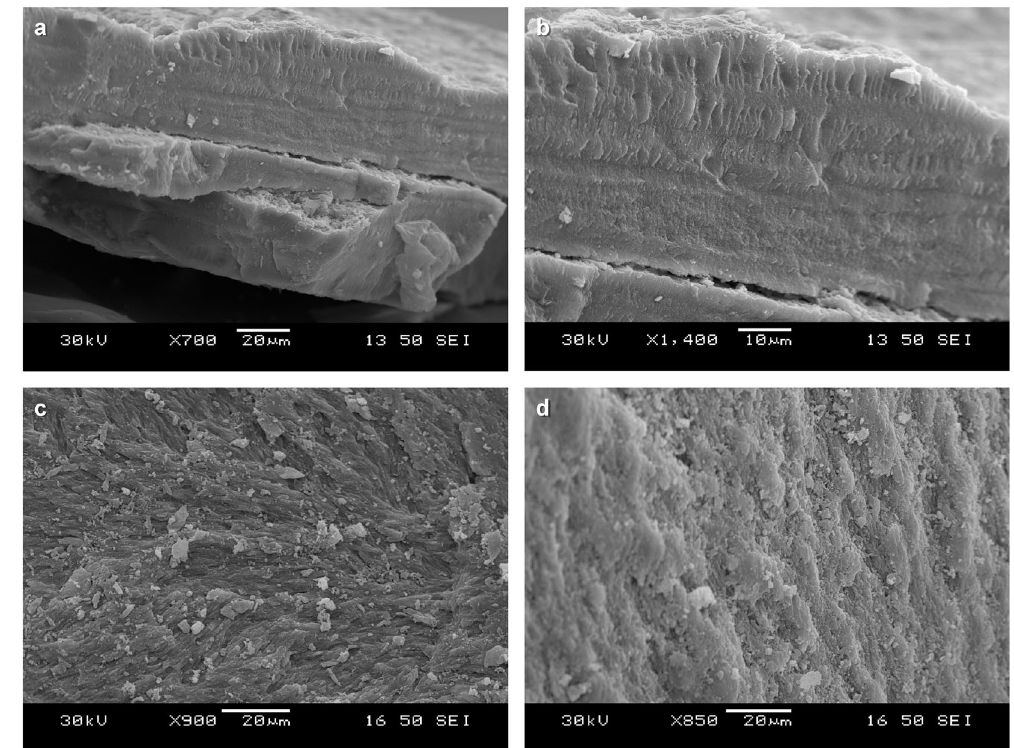
Fig. 3 SEM photos of the gladius N. hungarica . a Complete thickness of the gladius in the median fi eld area (central part of the gladius) with marked lamination, identical to the Recent gladius-bearing coleoids. b Detail of laminated gladius. c , d Details of the gladius surface. Note, the original β -chitin material has predominantly been replaced by (hydroxyl)apatite and gypsum during diagenetic and postdiagenetic